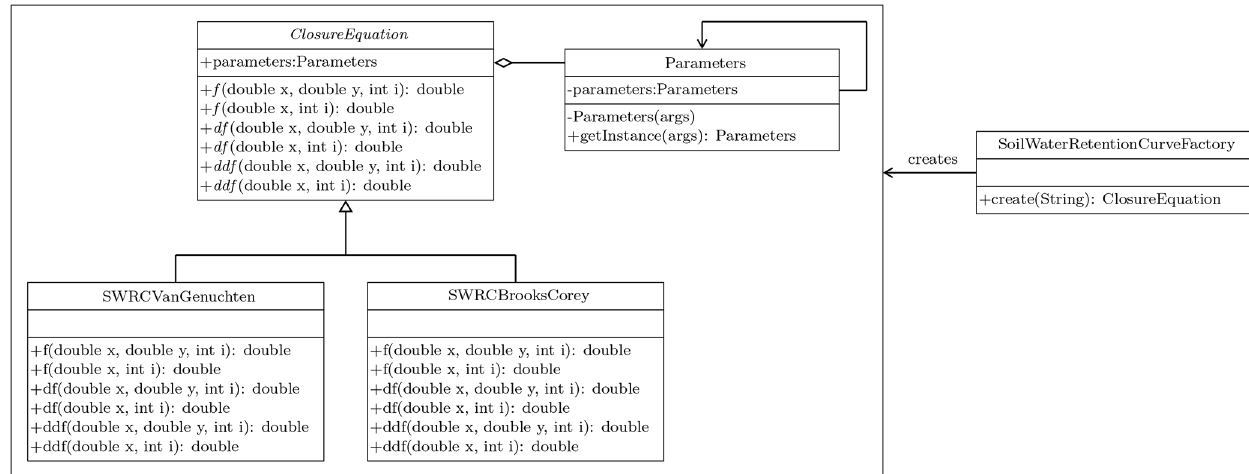
Figure 3. UML class diagram for the Java Simple Factory applied for the choice of the SWRC model. The ClosureEquation defines the interface that is implemented by the concrete classes SWRCVanGenucthen and SWRCBrooksCorey . The ClosureEquation is aggregated with the class Parameters containing the physical parameters of the model. Parameters is implemented by using the Singleton pattern, and its instance is inherited by the concrete classes SWRCVanGenucthen and SWRCBrooksCorey .